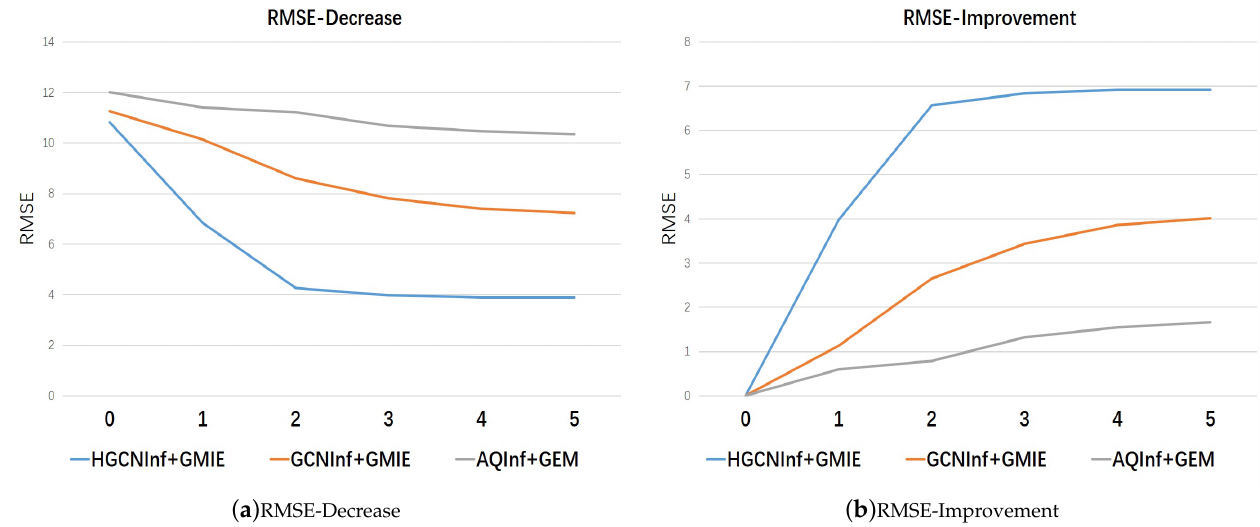
Figure 13. The MAPE results when gradually increase the number of recommended stations according to its priority.